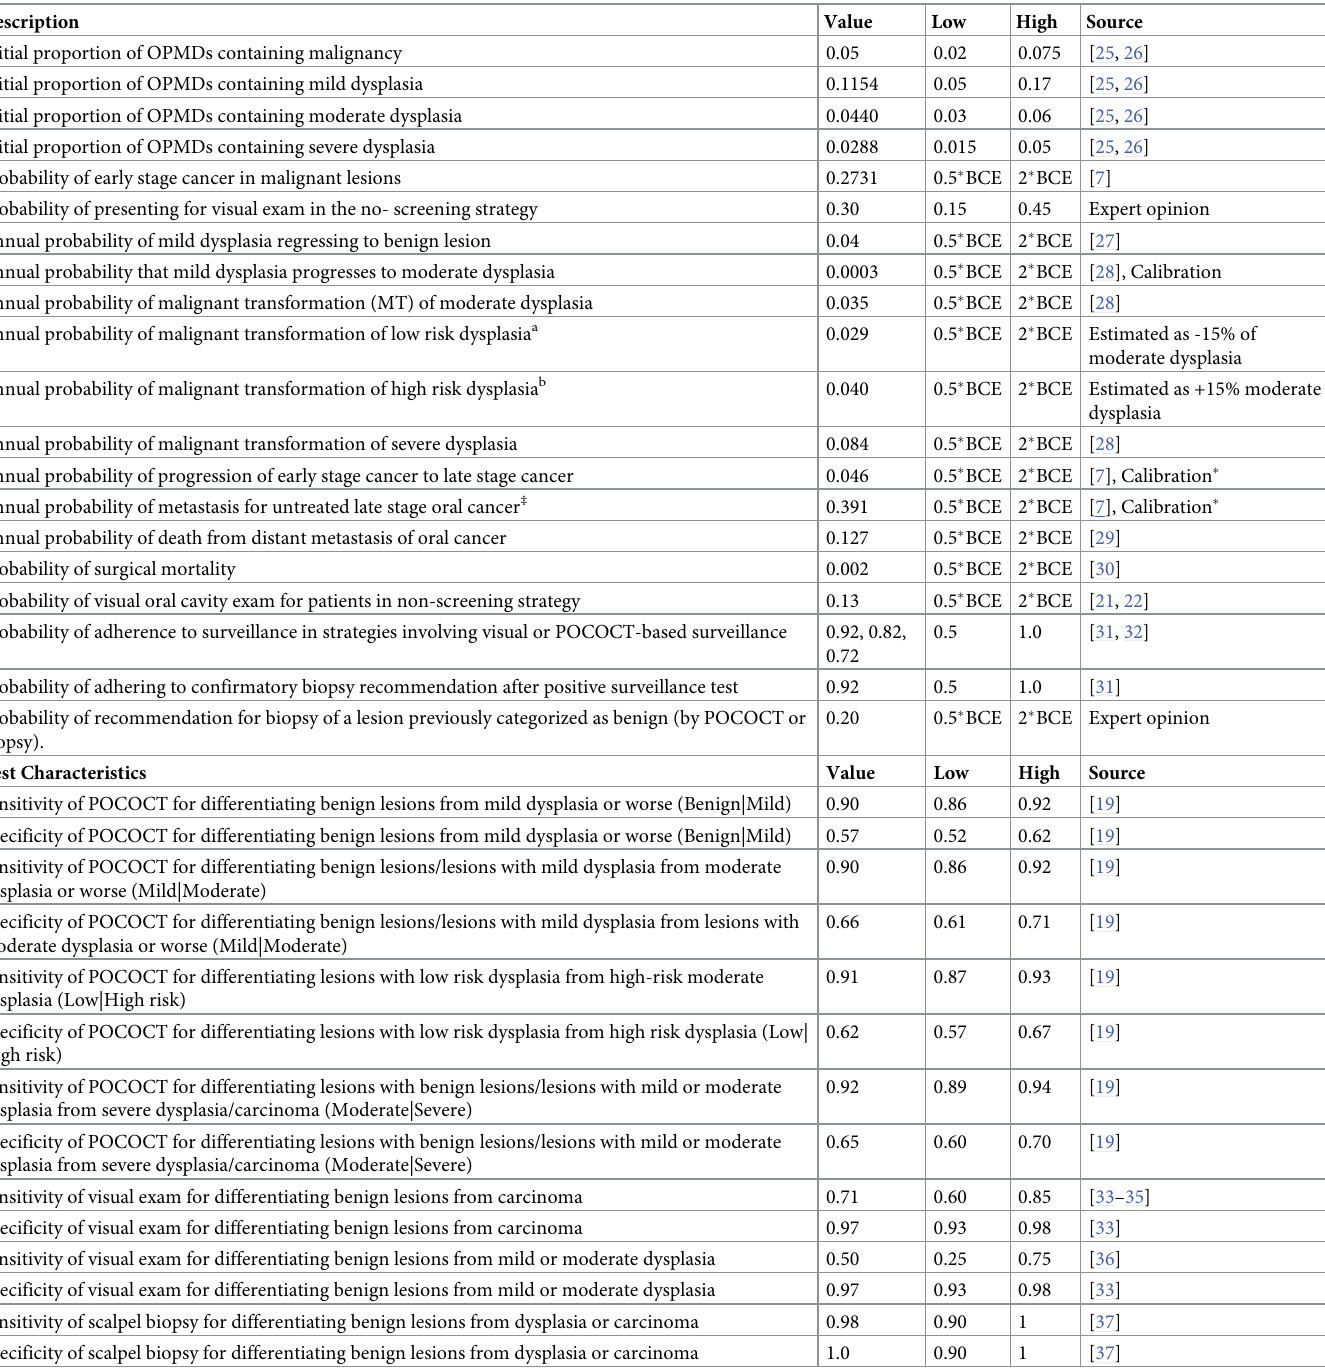
Table 1. Major parameters used in the model, including base case values and range for sensitivity